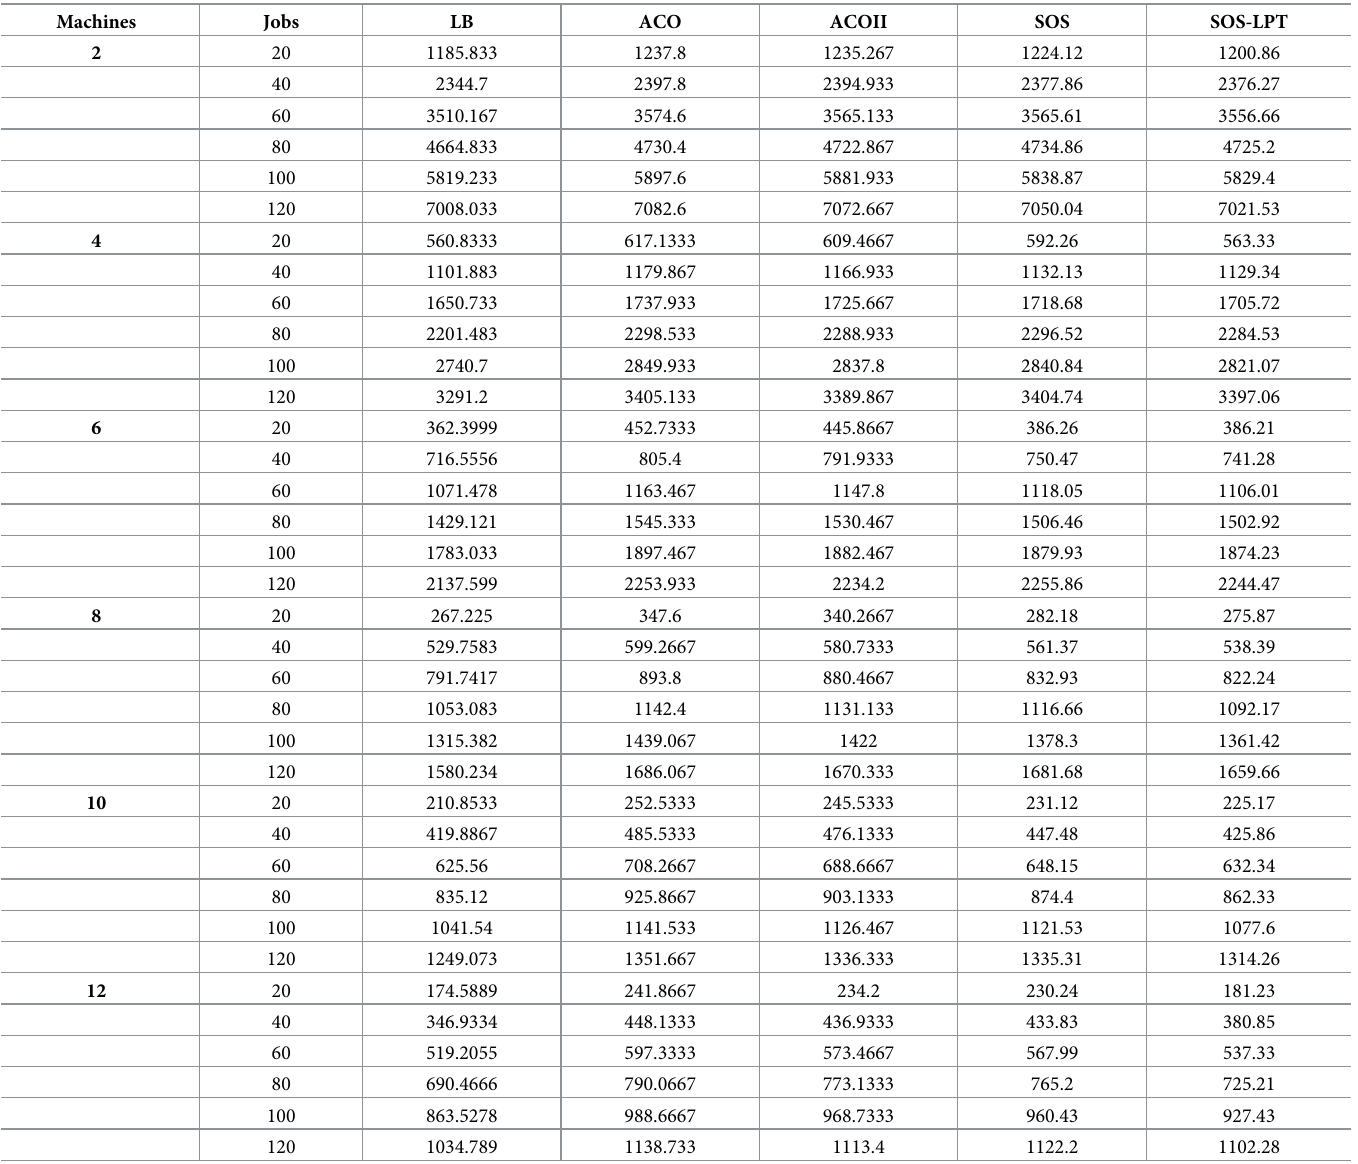
Table 5. Experimental results for 15 replicated runs of ACO, ACOII, SOS, and SOS-LPT algorithms.